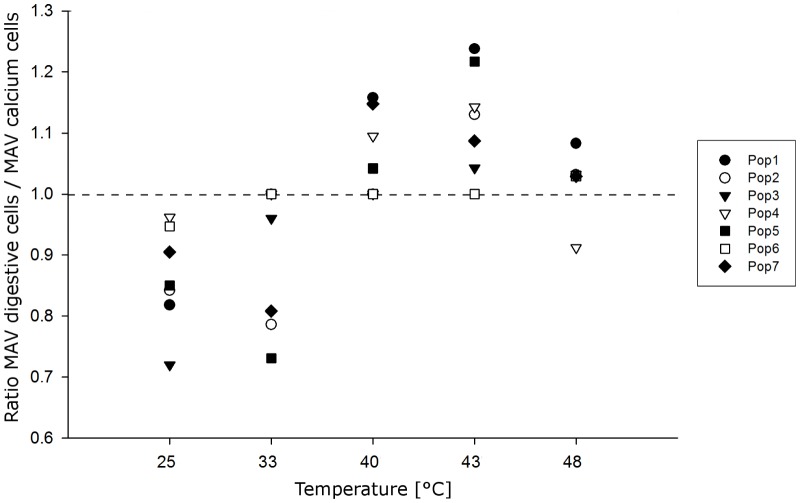
Ratio of the mean assessment values obtained for digestive cells and calcium cells.The ratio for each population at different temperature regimes is illustrated. Data below the dashed line indicate a better condition of digestive cells, compared to calcium cells. Data above the line indicate the opposite.